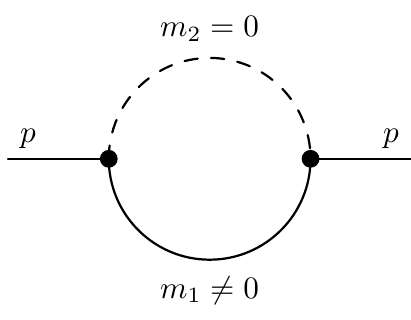
Figure 1 . The 1-loop 2-point function with one